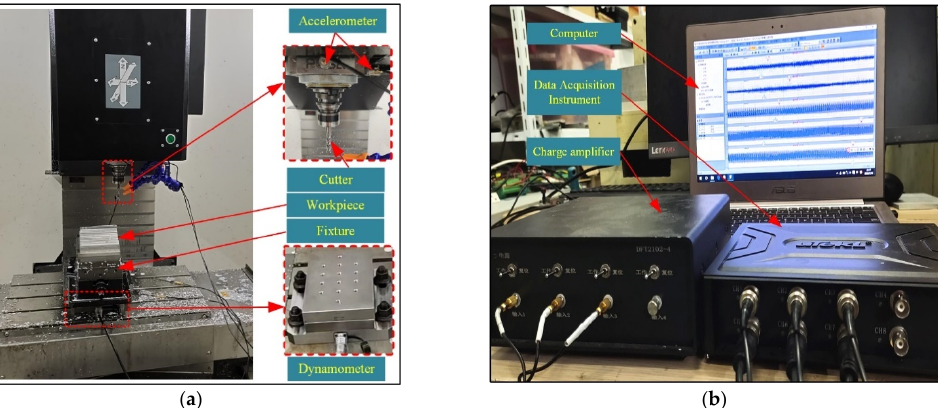
Figure 3. Experimental setup for chatter detection. ( a ) Configuration of machine; ( b ) Data-acquisition and analysis system.